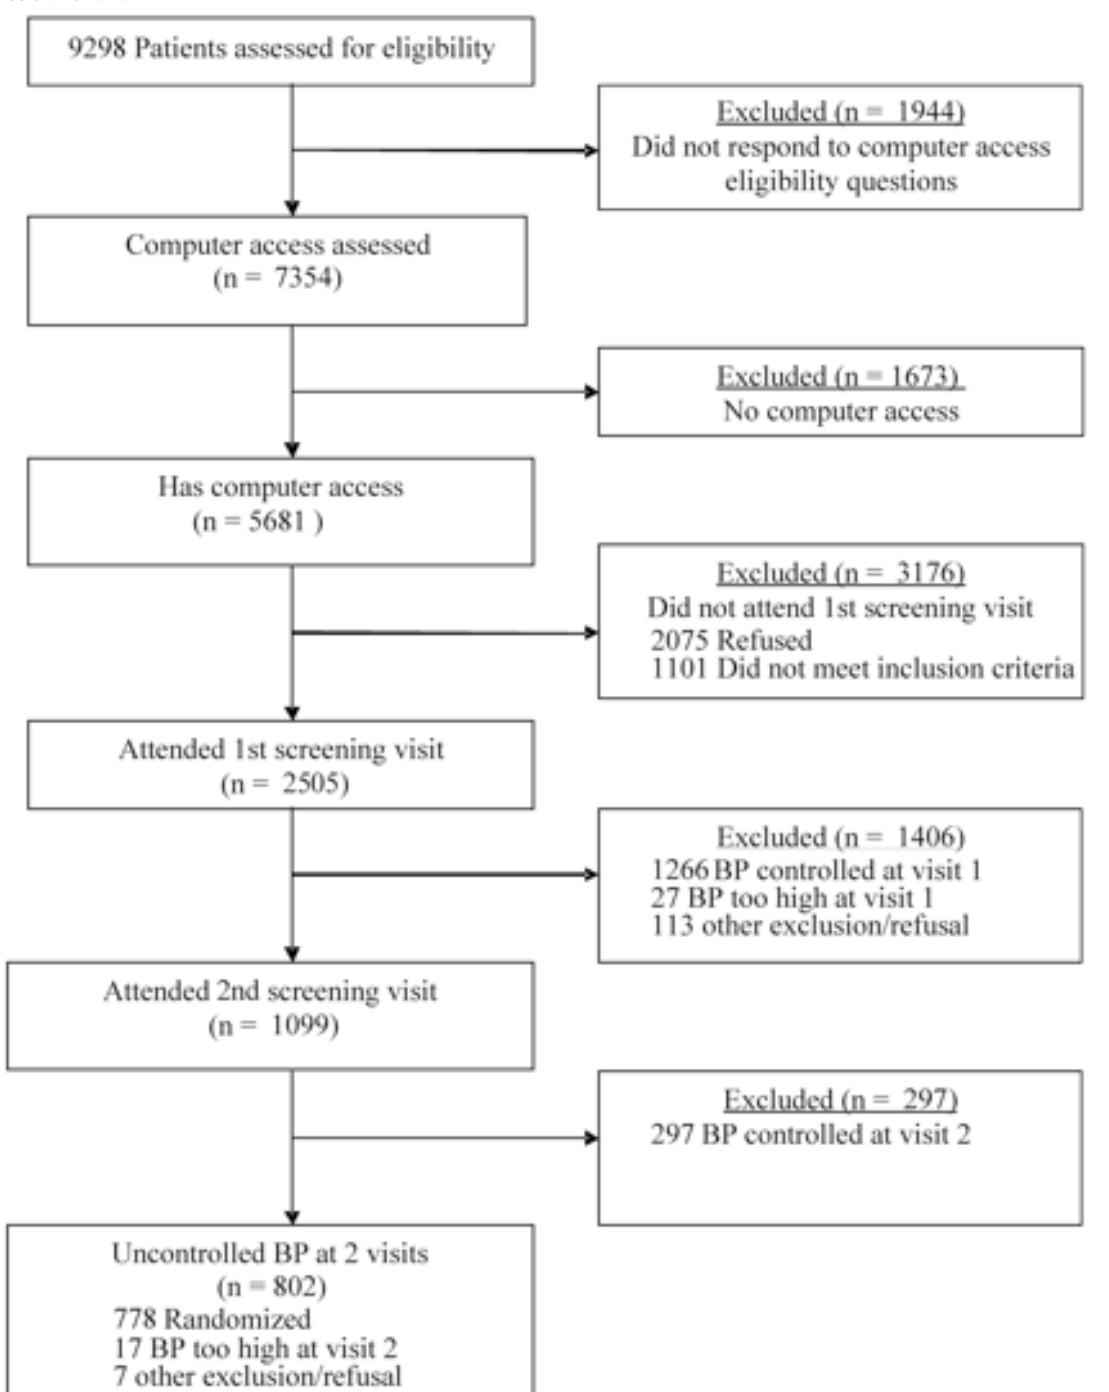
Figure 1. Recruitment